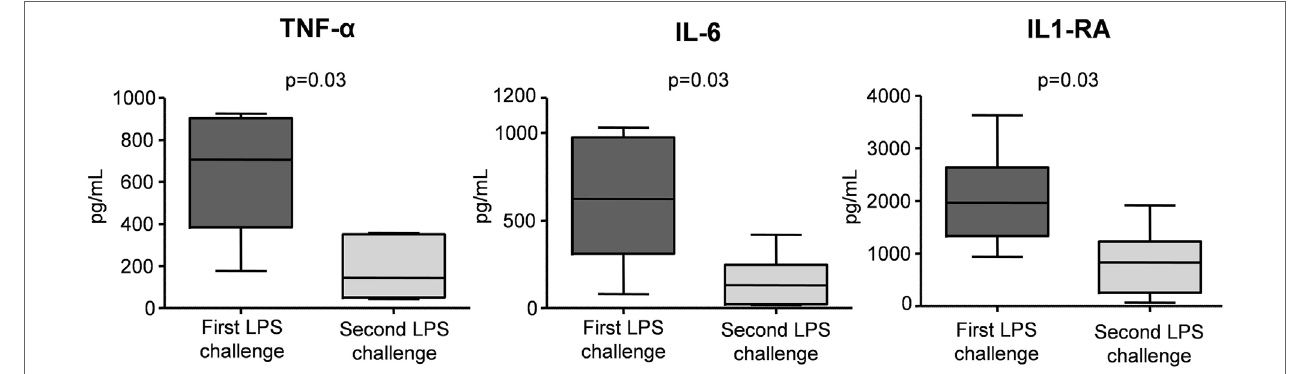
FigUre 6 | Peak plasma levels of IL-1RA, IL-6, and TNF- α in six subjects who were challenged with lipopolysaccharide (LPS) twice, separated by 1 week. Data are represented as Box and Whisker (Min to Max) plots of individual peak levels of plasma cytokine concentrations during the first and second lipopolysaccharide (LPS) challenge. Data previously published (3).